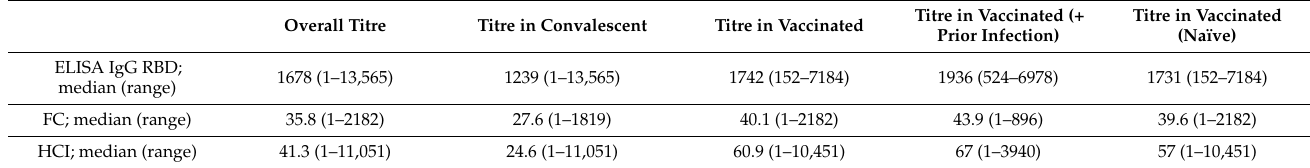
Table 1. Median and range of quantitative antibody titres between methods and studied groups/subgroups.